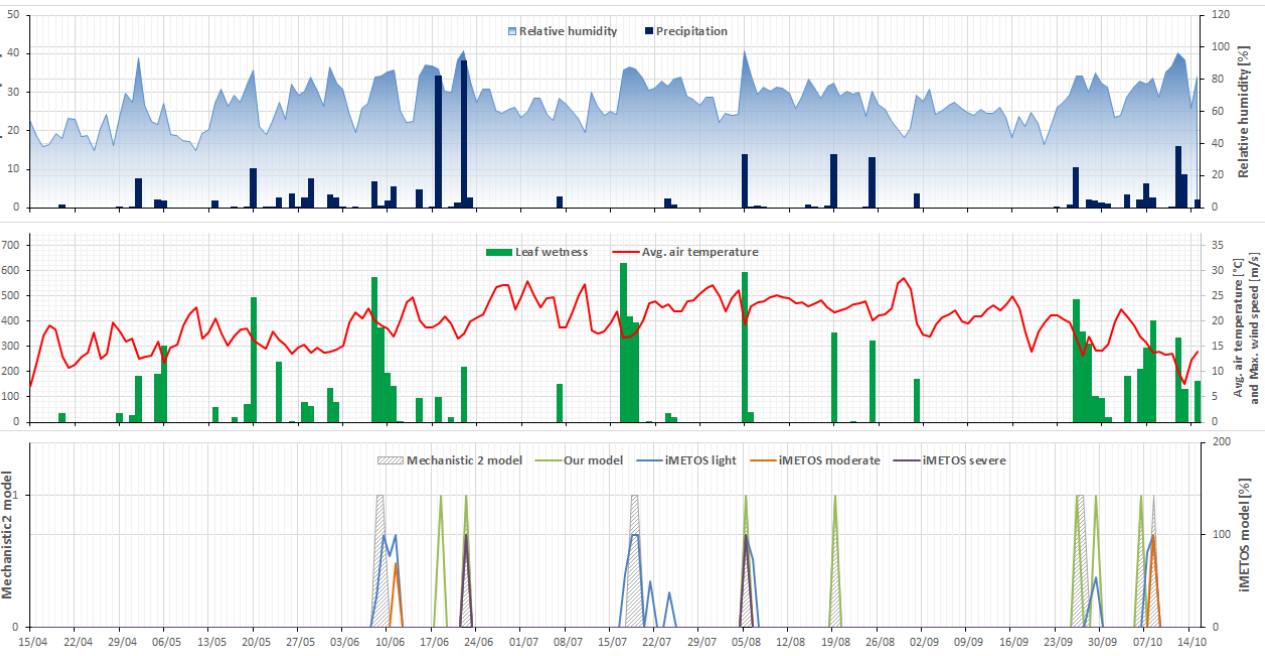
Figure 16. Secondary infection alarms for the location ’Rimski